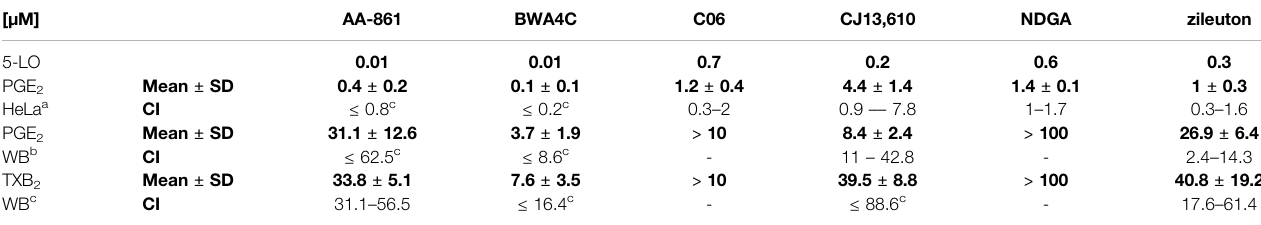
TABLE 1 | Comparison of literature-derived IC 50 values for 5-LO inhibition and IC 50 values obtained for inhibition of PG release in cytokine stimulated HeLa cells and human whole blood preparations. IC 50 values for inhibition of 5-LO activity were obtained from the literature (Ménard et al., 1990; Fischer et al., 2010; Hofmann et al., 2012). CI, con fi dence interval; NDGA, nordihydroguaiaretic acid; SD, standard deviation; WB, human whole blood.